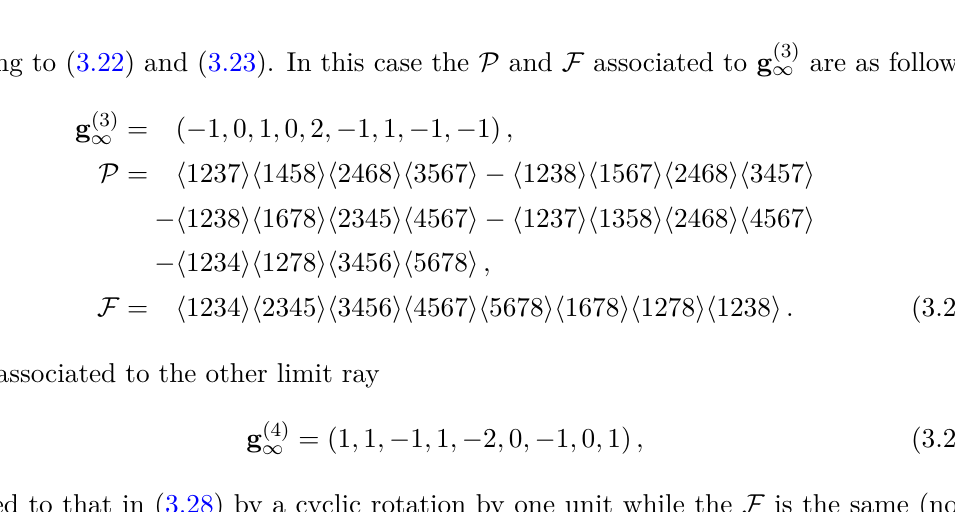
Table 2 . Four types of clusters that act as origins of doubly-infinite